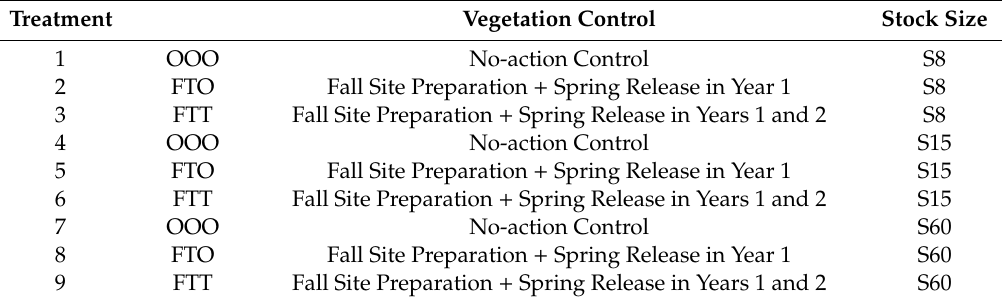
FTT Fall Site Preparation + Spring Release in Years 1 and 2